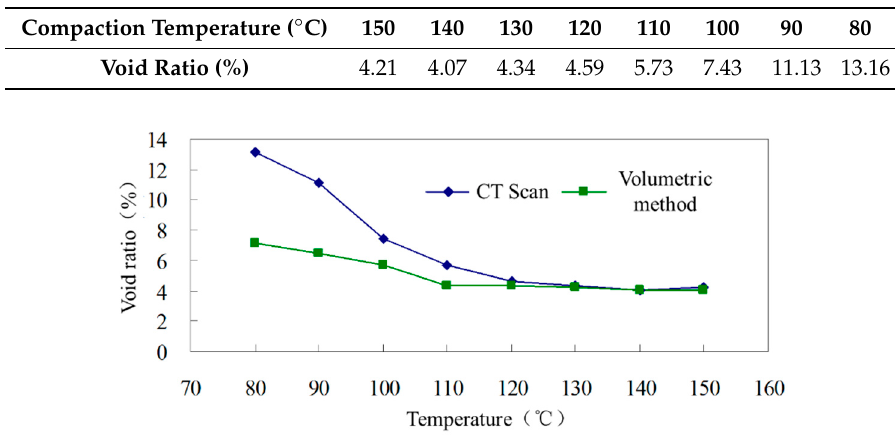
Figure 4. Change of void ratio at different compacting temperatures.